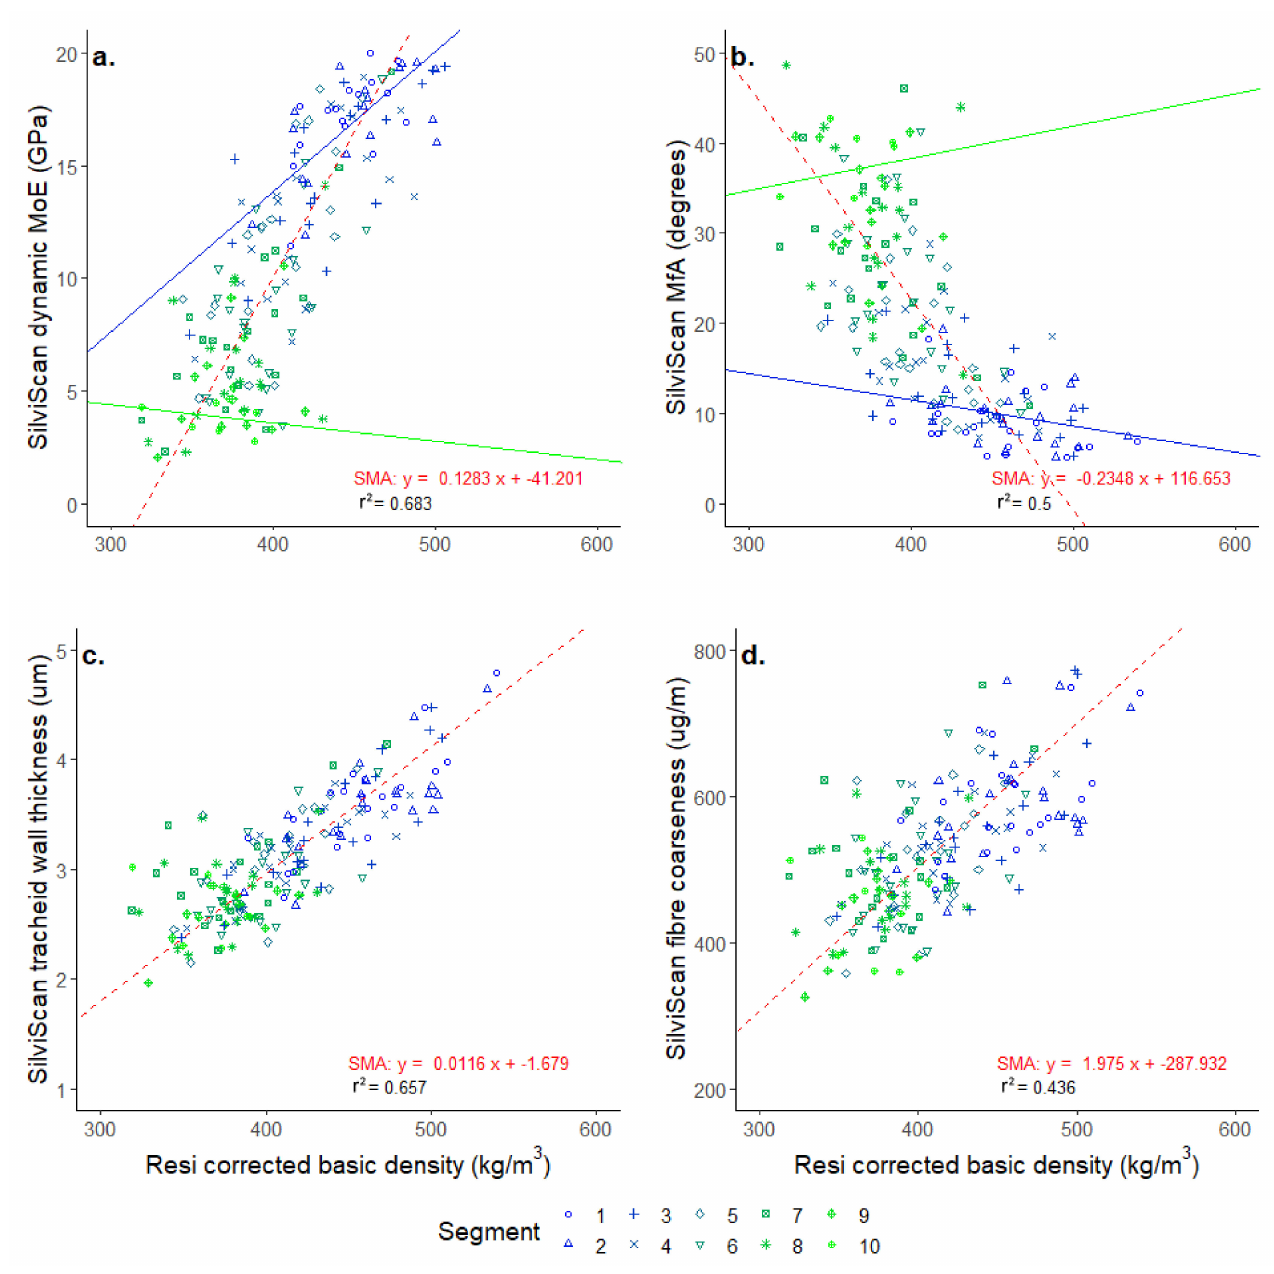
Figure 10. Resi-corrected density was strongly correlated with ( a ) SilviScan MoE, ( b ) MfA, ( c ) tracheid wall thickness and ( d ) fibre coarseness. The solid lines in ( a , b ) indicate the slope of the regressions within segments 2 (close to bark) and 10 (close to